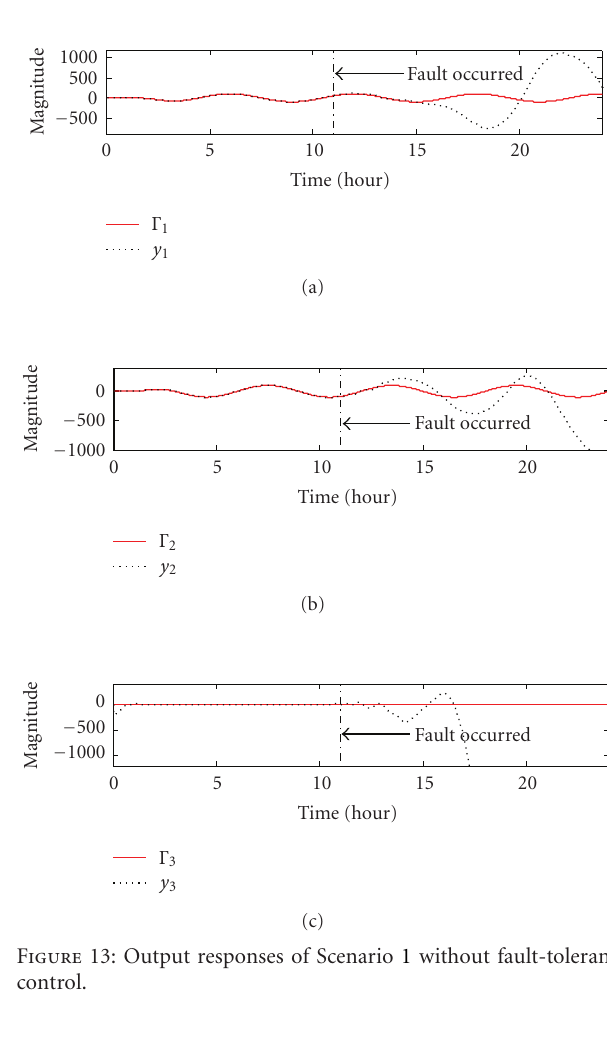
thruster nozzle. x